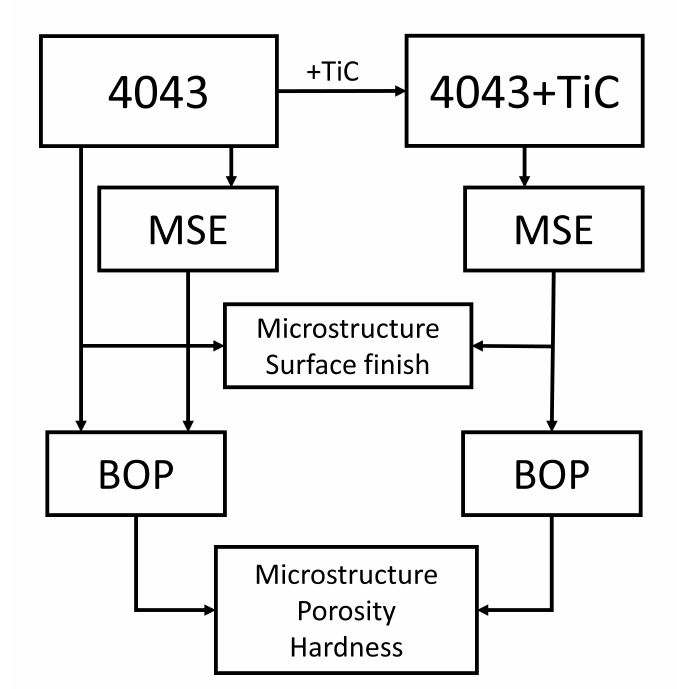
Figure 2. Flowchart for development of feedstock wires for wire and arc additive manufacturing (WAAM) by metal screw extrusion (MSE). Commercial AA4043 wire was used as starting material and benchmark. Bead-on-plate (BOP) deposition simulates a WAAM base